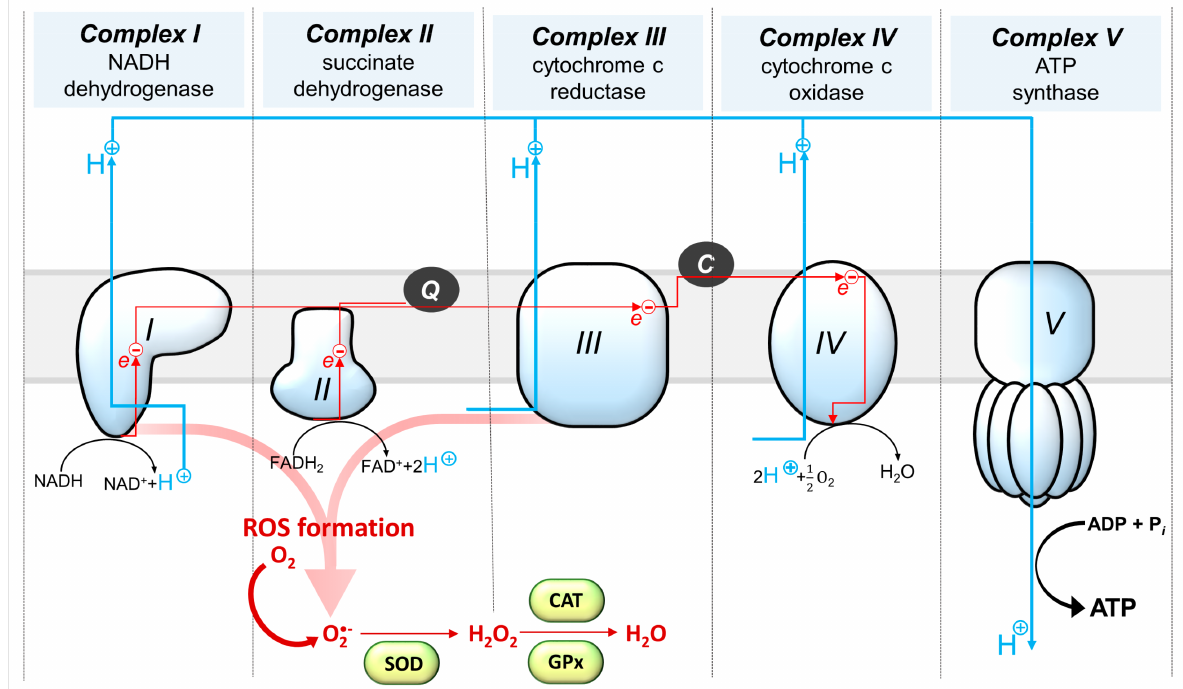
Figure 1. Schematic representation of mitochondrial respiratory chain complexes, outlining the sites of reactive oxygen species (ROS) generation and mitochondrial enzymes involved in the maintenance of proper redox status. Q—coenzyme Q; C—cytochrome C; SOD—Superoxide dismutase; GPx—glutathione peroxidase;